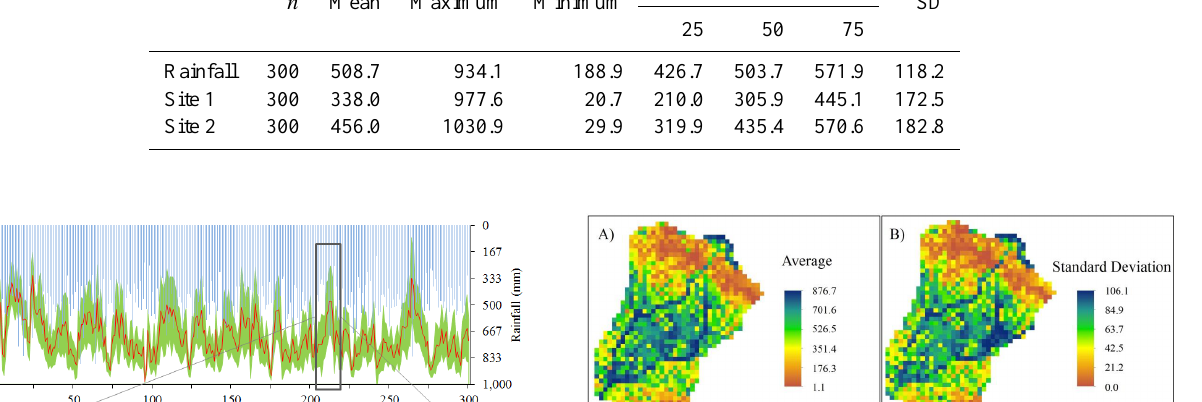
Table 5. Descriptive statistics for simulated rainfall (mm) and simulated average pasture production (kgDMha − 1 year − 1 ) for each site and 300years. n